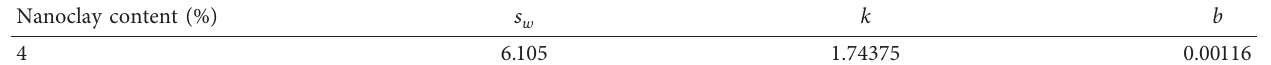
Table 10: s w , k , and b values with different nanoclay